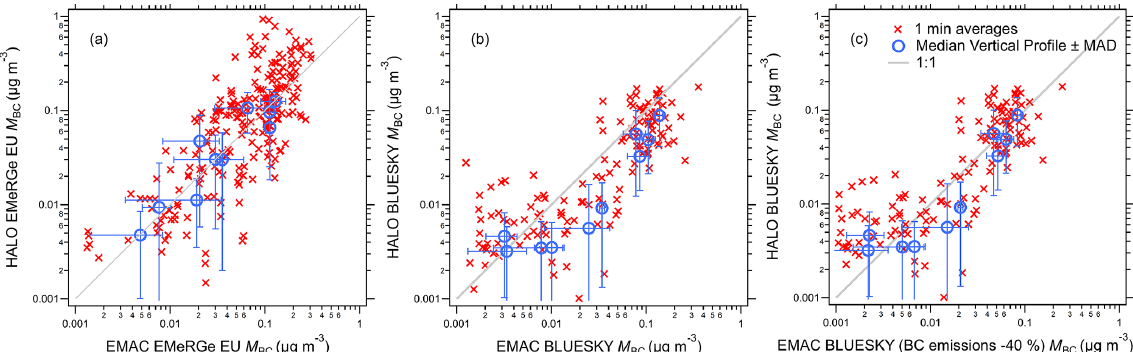
Figure 3. Scatter plot for median M BC values of HALO measurements and EMAC model results. Red data show the comparison of 1min averages. In blue median concentrations as used for the vertical profiles are shown. Error bars are one median absolute deviation (MAD) for the vertical merged data in 500m altitude bins. Data shown are for the compared altitude up to 5000m. Panel (a) corresponds to measurements from 2017 with R 2 = 0.76. Panel (b) indicates 2020 measurements with initial emissions in the EMAC model and R 2 = 0.90. Panel (c) is as (b) but with 40% reduced anthropogenic emissions in EMAC simulation and R 2 =